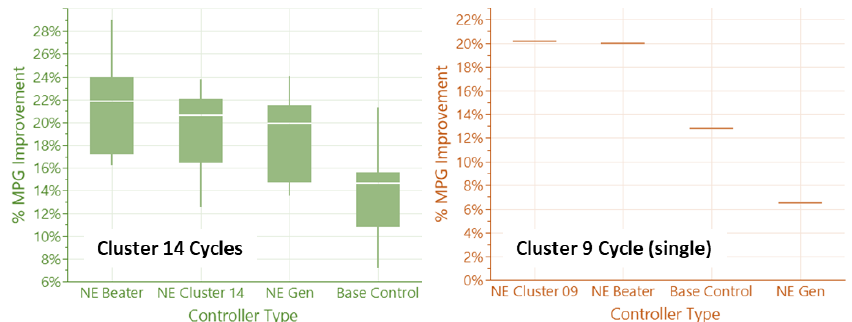
Figure A2. Controller performance comparison showing the improvement of the NE Cluster con- troller from the General NE controller. The remaining optimal gap is shown versus the NE Beater controller. Cluster 9, containing only one cycle, shows a slightly better performance than the NE Beater due to the transfer learning step and the extra optimization time that it was allowed to